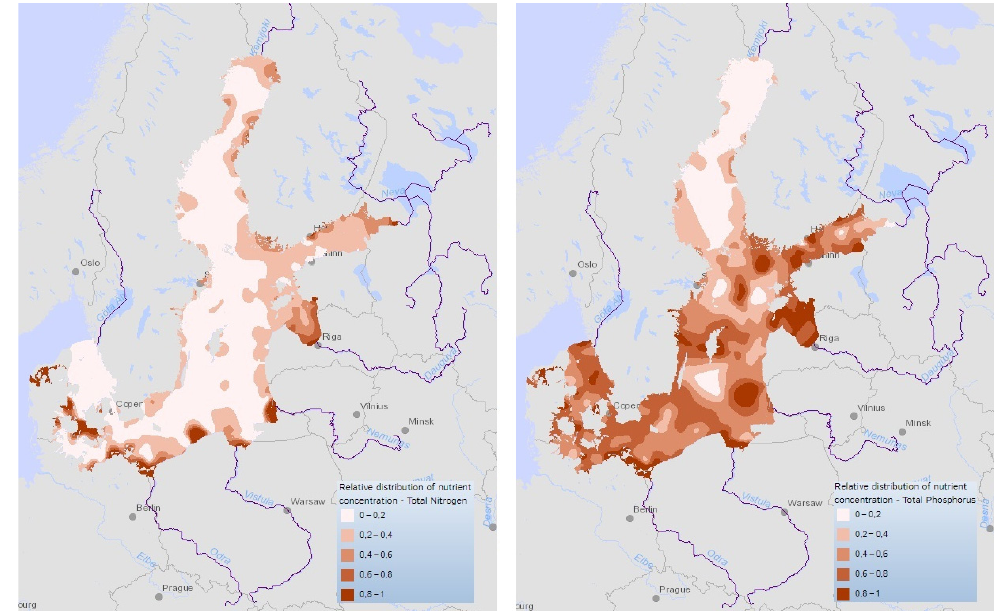
Figure 1. Distribution of nutrient concentration ( μ g/dm 3 ) in the surface water of the Baltic Sea, based on HELCOM Map and Data Service [5].